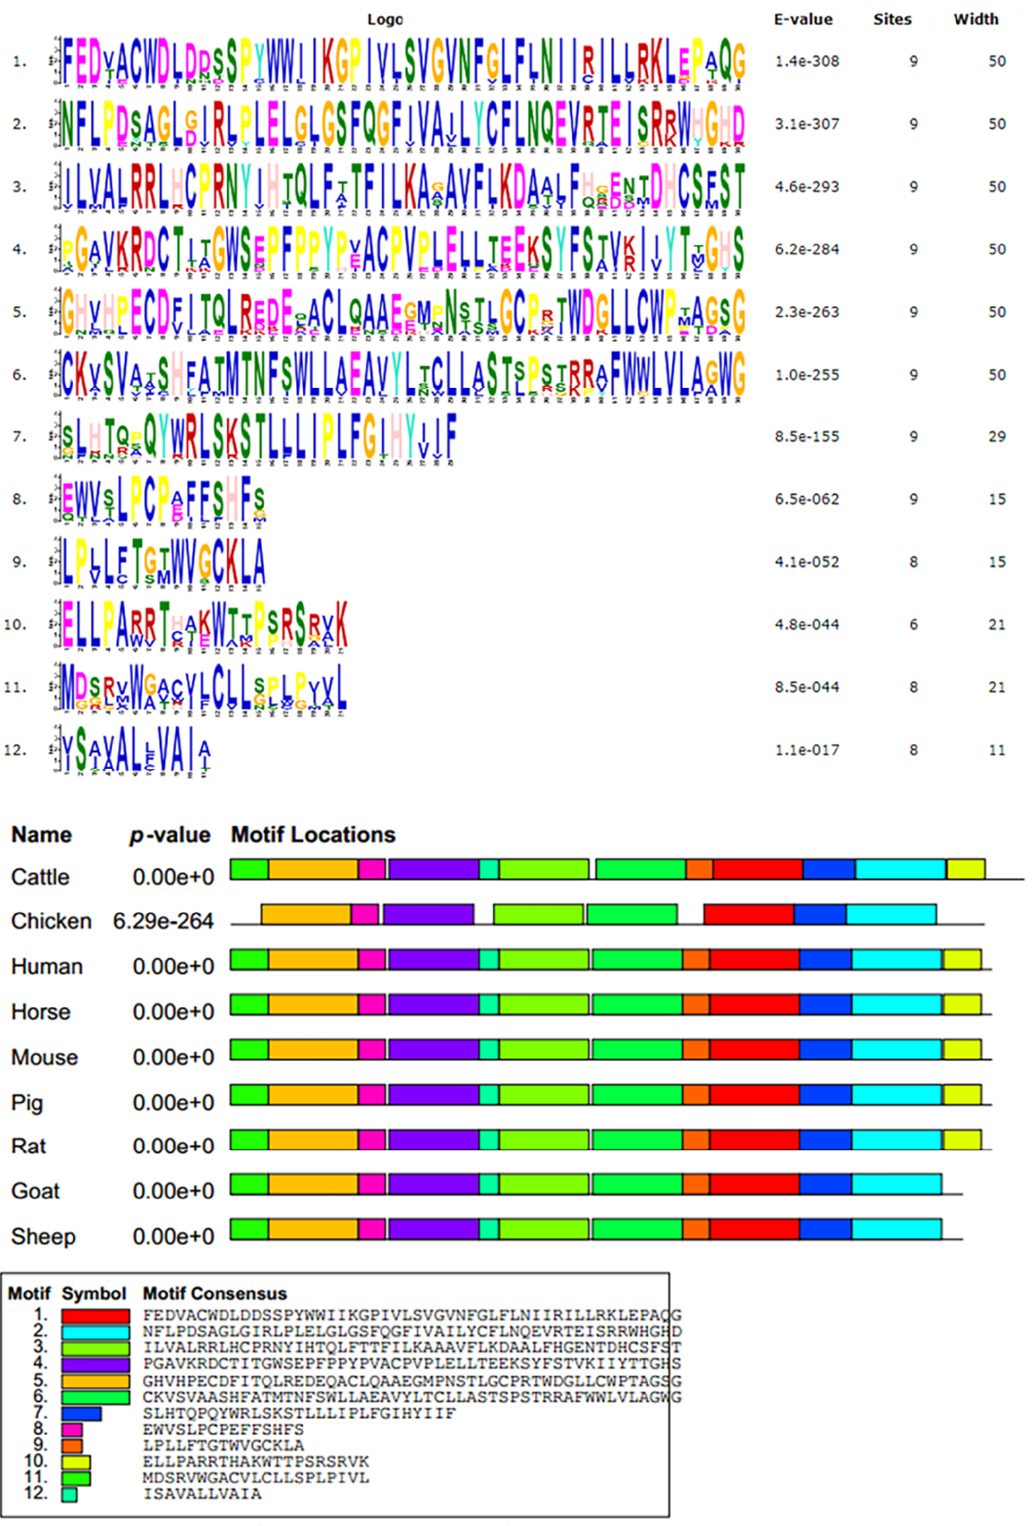
Figure 3. The significant motifs of GHRHR protein sequences in nine animals. These colors were given by MEME suit system during analysis.